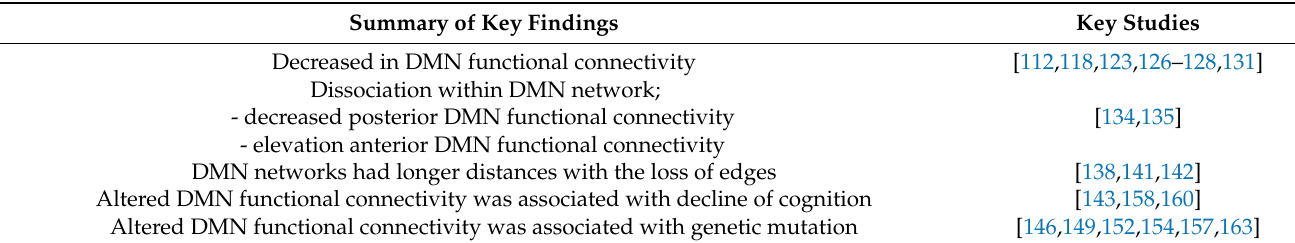
Table 2. Summary of key findings of rs-fMRI studies associated with the default mode network (DMN) in Alzheimer’s disease (AD) and mild cognitive impairment (MCI) patients included in the